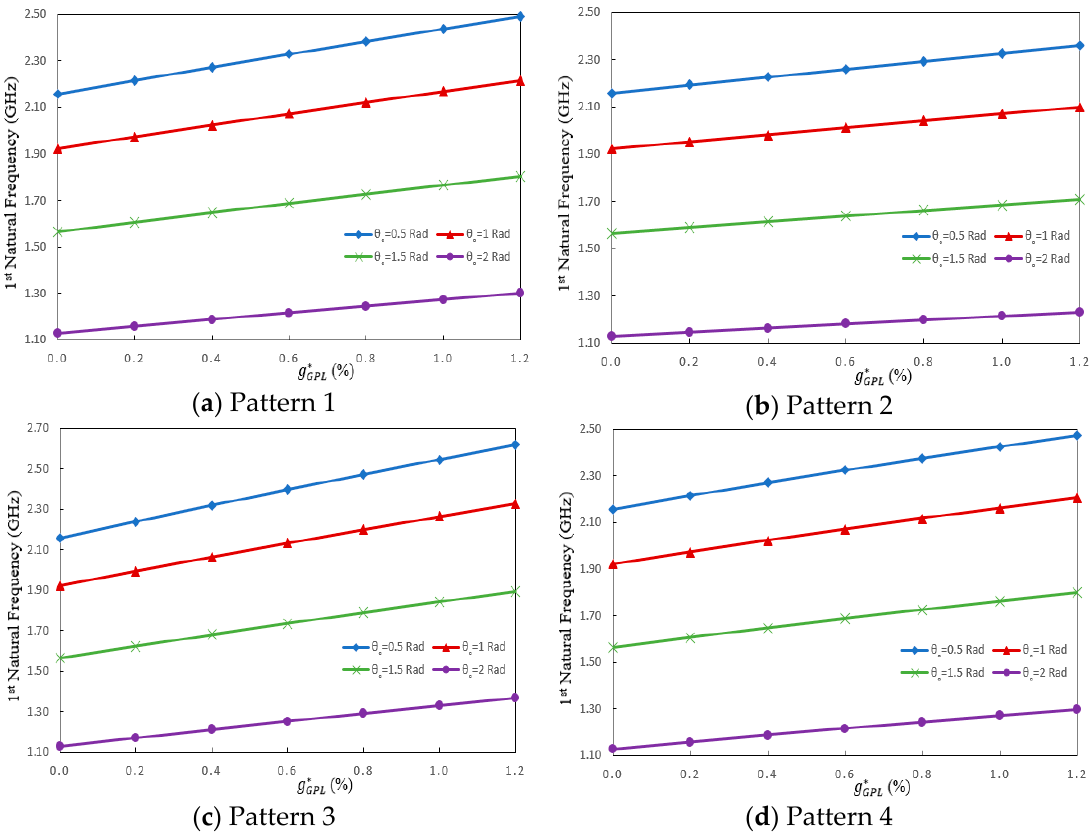
Figure 4. Effect of the GPL weight fraction and opening angle 𝜃 ᴏ on the 1 st natural frequency (GHz) Figure 4. E ff ect of the GPL weight fraction and opening angle θ 0 on the 1 st natural frequency (GHz) of of the composite curved nanobeam; 𝑁 (cid:3013) (cid:3404) 12 , 𝜇 (cid:3404) 1 𝑛𝑚 , 𝑘 (cid:2869) (cid:3404) 𝑘 (cid:2870) (cid:3404) 0 . the composite curved nanobeam; N L = 12, µ = 1 nm , k 1 = k 2 =